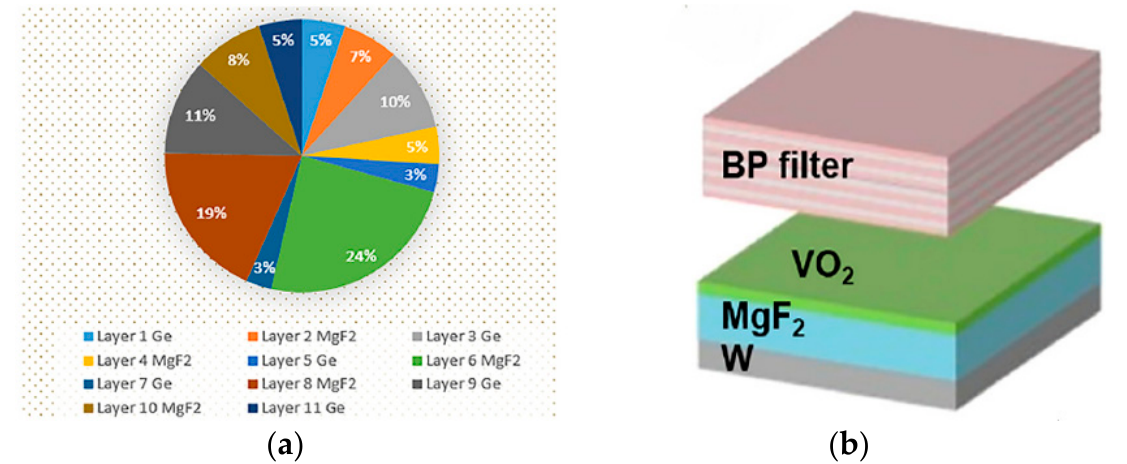
Figure 25. ( a ) Material thickness for the proposed DPRC material and ( b ) self-adaptive diurnal radiative cooling structure [134].